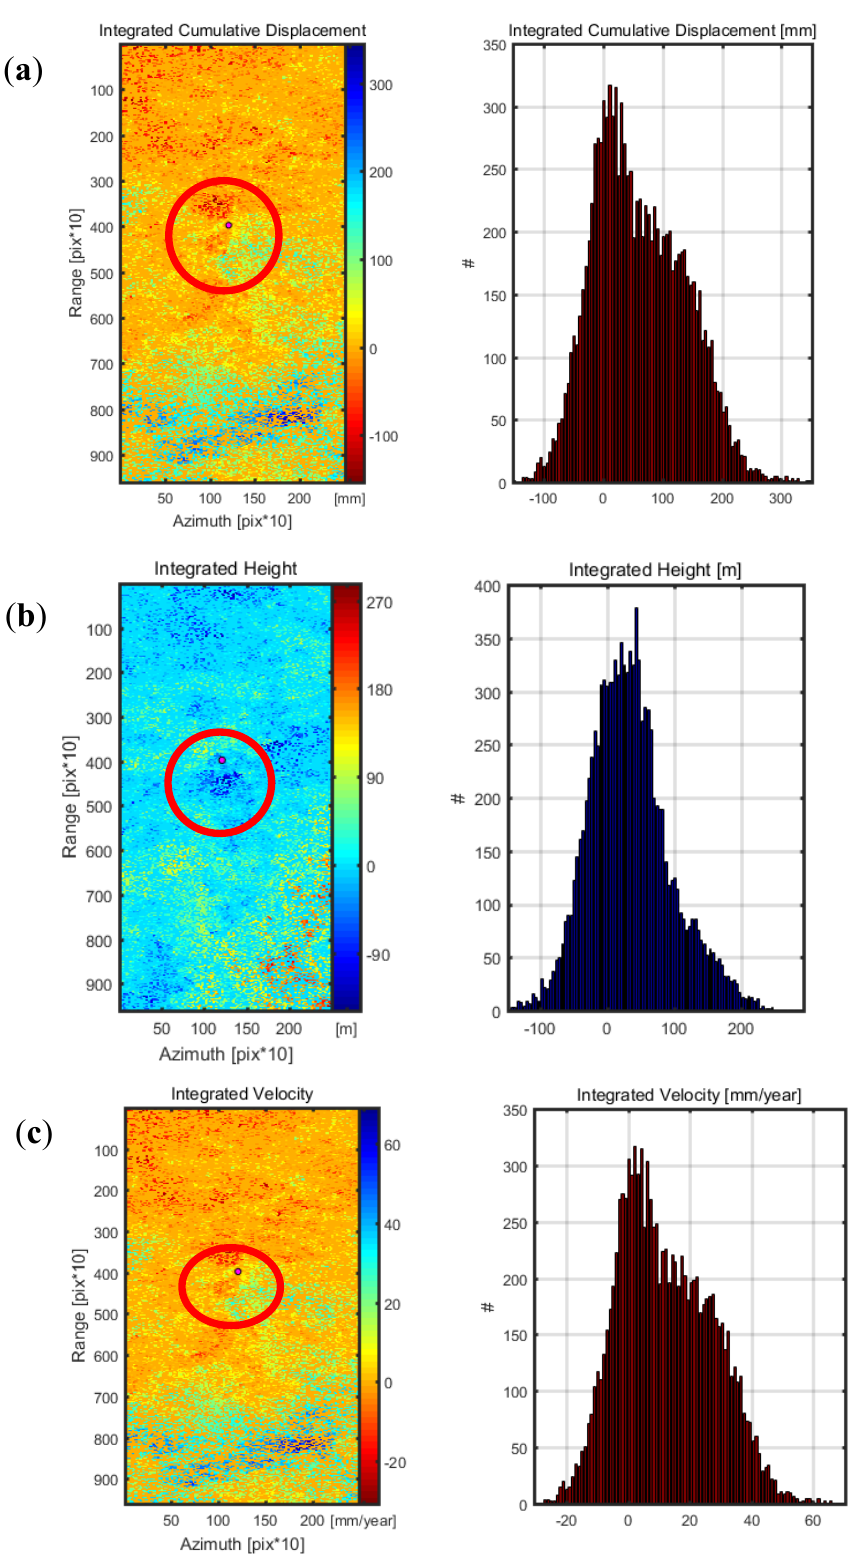
Figure 12. Graph plots for PS Point as shown in Red Circle ( a ) integrated cumulative displacement (in mm), ( b ) height of the PS point under study (in m), and ( c ) cumulative velocity from 2017 to 2022 (in mm/year).